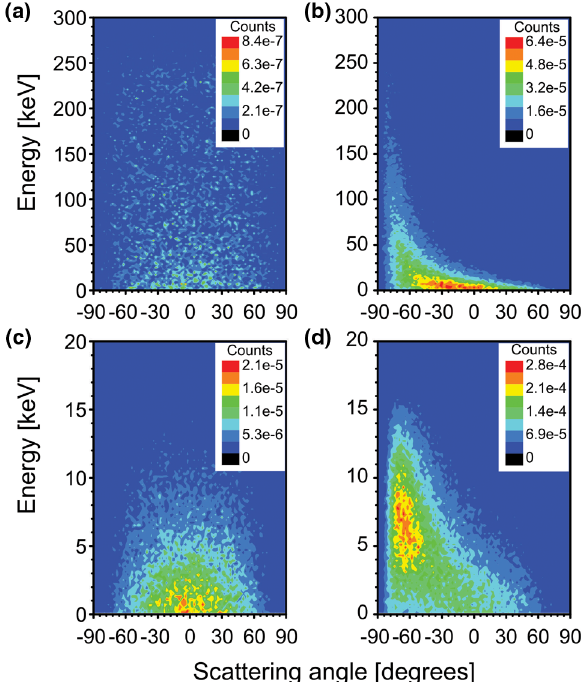
FIG. 15. Backscattered energy distribution as a function of scattering angle for 300 keV protons impinging on a copper surface at 0 (cid:3) and 75 (cid:3) [(a) and (b), respectively] and 20 keV protons impinging at 0 (cid:3) and 75 (cid:3) [(c) and (d), respectively]. The counts are given as a fraction of the number of simulated incident protons: (a) 1 : 8 (cid:2) 10 7 , (b) 1 : 4 (cid:2) 10 6 , (c) 1 : 5 (cid:2) 10 6 , and (d) 2 : 8 (cid:2) 10 5